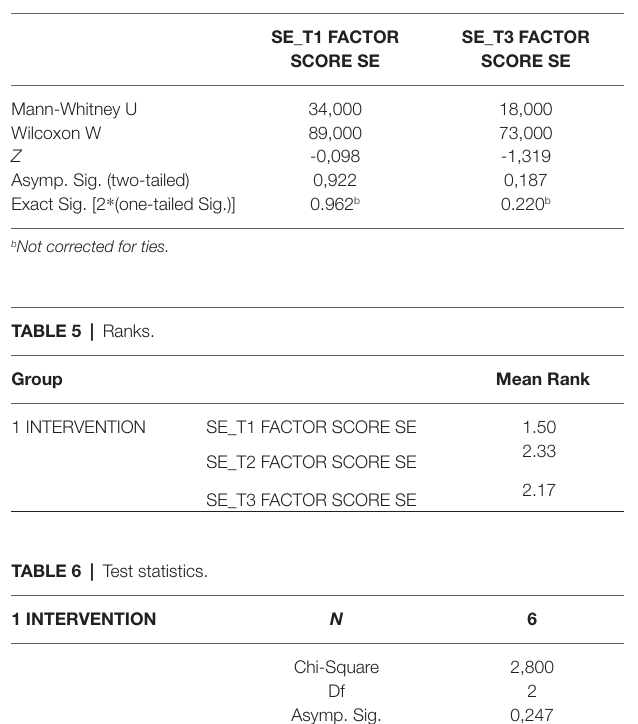
TABLE 7 | Intervention group self-efficacy over Time 1, 2, and